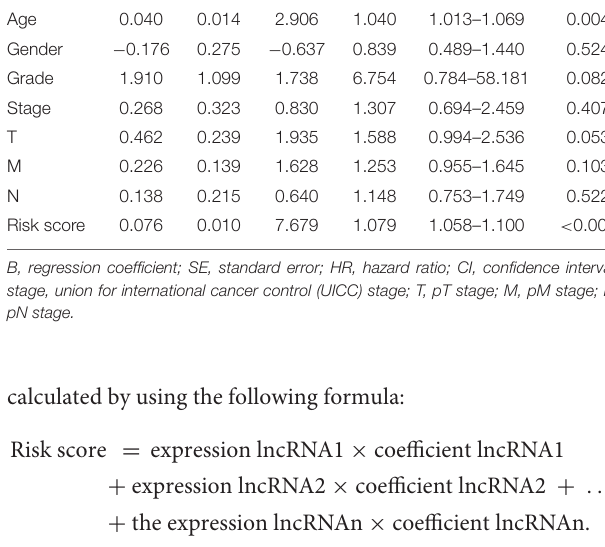
FIGURE 4 | Multi-factor receiver operating characteristic (ROC) curve. The area under the curve (AUC) value of the model established in the training group is significantly more than 0.7, and is greater than the predicted value of clinical data. TABLE 4 | lncRNA clinical correlation